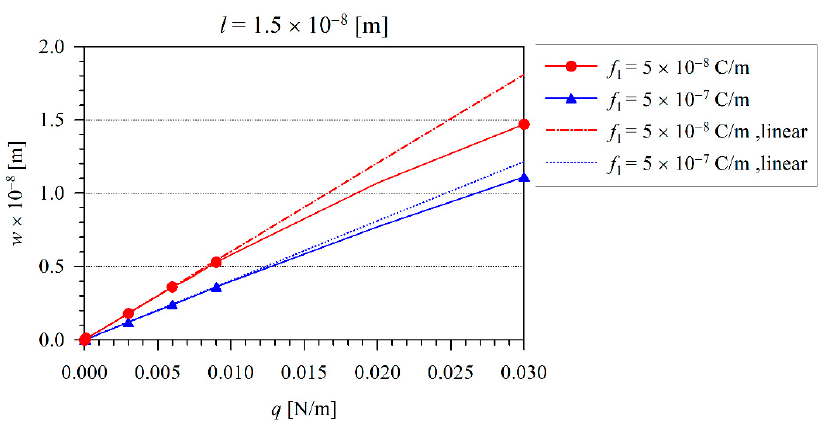
Figure 6. The variation of maximal beam deflection w with the load q for various flexoelectric coefficients and at the microstructural length-scale material parameter l = 1.5 × 10 − 8 . The variation of maximal deflection w with the intrinsic parameter l for two different − = × 8 loading levels and at the flexoelectric coefficient 5 10 C/m f is shown in Figure 7. Both 1 of the curves for the two different load intensities are nearly parallel. Figure 7. The variation of maximal deflection w with the intrinsic parameter l for two different load- ing levels and at the flexoelectric coefficient 8 1 5 10 C/m f − = × . The influence of the flexoelectric coefficient on the maximal beam deflection is clearly visible in Figures 8 and 9 for two different values of the microstructural length-scale pa- rameter. Here, one can observe that the deflection response is lower for the beam with the larger value of the microstructural length-scale parameter. The beam deflection decreases with the increasing value of the flexoelectric coefficient.